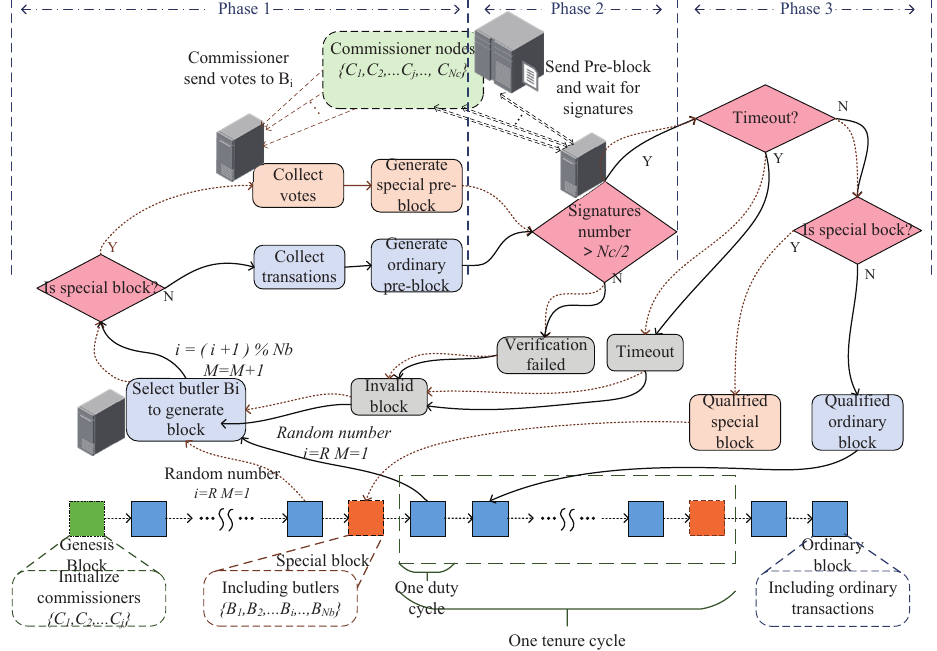
Figure 5. PoV consensus and block generation